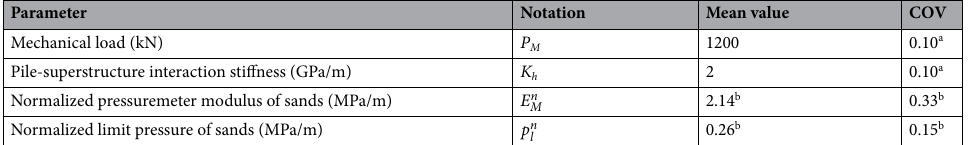
Table 2. Uncertain parameters used in the reliability analysis. a Xiao et al. 21 ; b data characterized using field test results from Szymkiewicz et al. 36 and Habert et al. 35